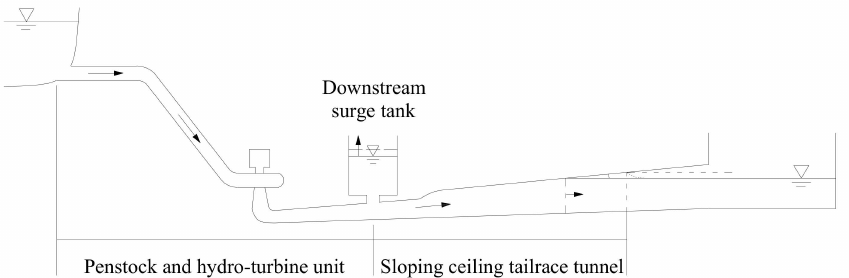
Figure 32. Layout of a hydropower plant with a downstream surge tank and an SCTT. Reproduced with permission from [52], Elsevier, 2018.